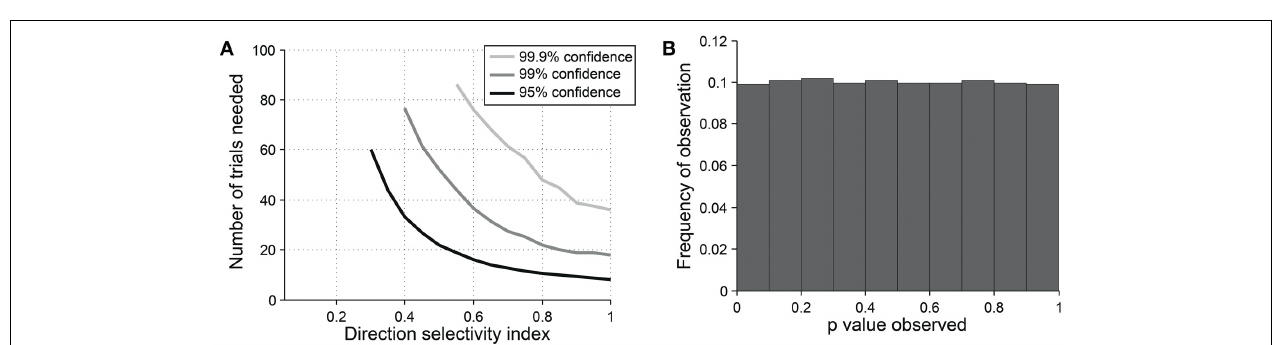
number of trials needed such that one would detect an OI difference of X with 95% confidence. (B) A cell was simulated with seven trials at underlying OI = 0. The simulation was repeated 200,000 times and each time a p -value was measured against H0: OI = 0. The frequency of observed p -values was uniform between 0 and 1, which is what would be expected for an unbiased test by repeated sampling of an unoriented cell.